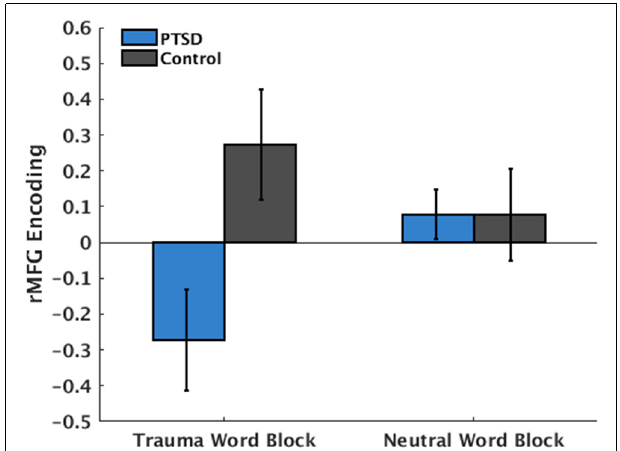
FIGURE 4 | PTSD × Valence interaction in the right middle frontal gyrus (rMFG). More negative values indicate the heightened encoding of words during the block. More positive values indicate the heightened encoding of faces during the block. Individuals with PTSD showed heightened encoding of words only when word content was trauma-related but encoded faces when word content was neutral. Control participants showed heightened encoding of faces, regardless of word content.